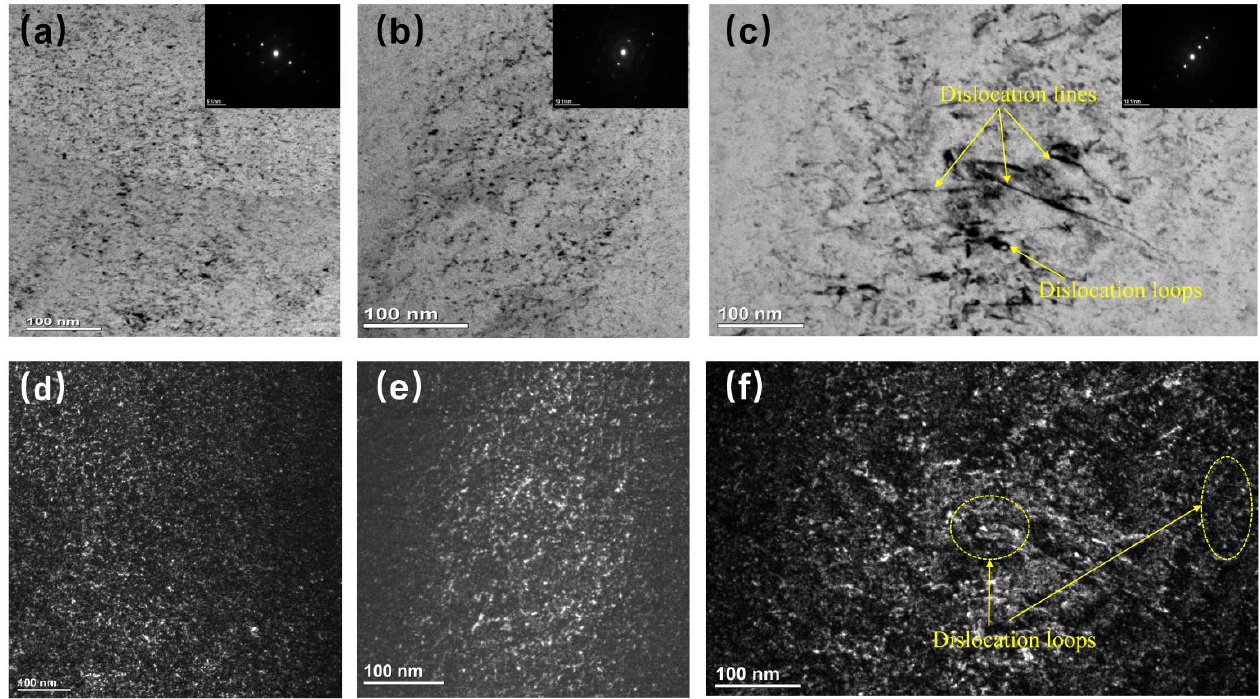
Figure 9. Enlarged BF and DF TEM images of Zr 40 Nb 35 Ti 25 samples irradiated by 3 MeV Fe 11+ ions: ( a ) 500 °C—8 × 10 15 , ( b ) 300 °C—2.5 × 10 16 , and ( c ) 500 °C—2.5 × 10 16 . ( d – f ) The corresponding weak-beam DF images. The g = <110> near the [111] zone axis was selected.